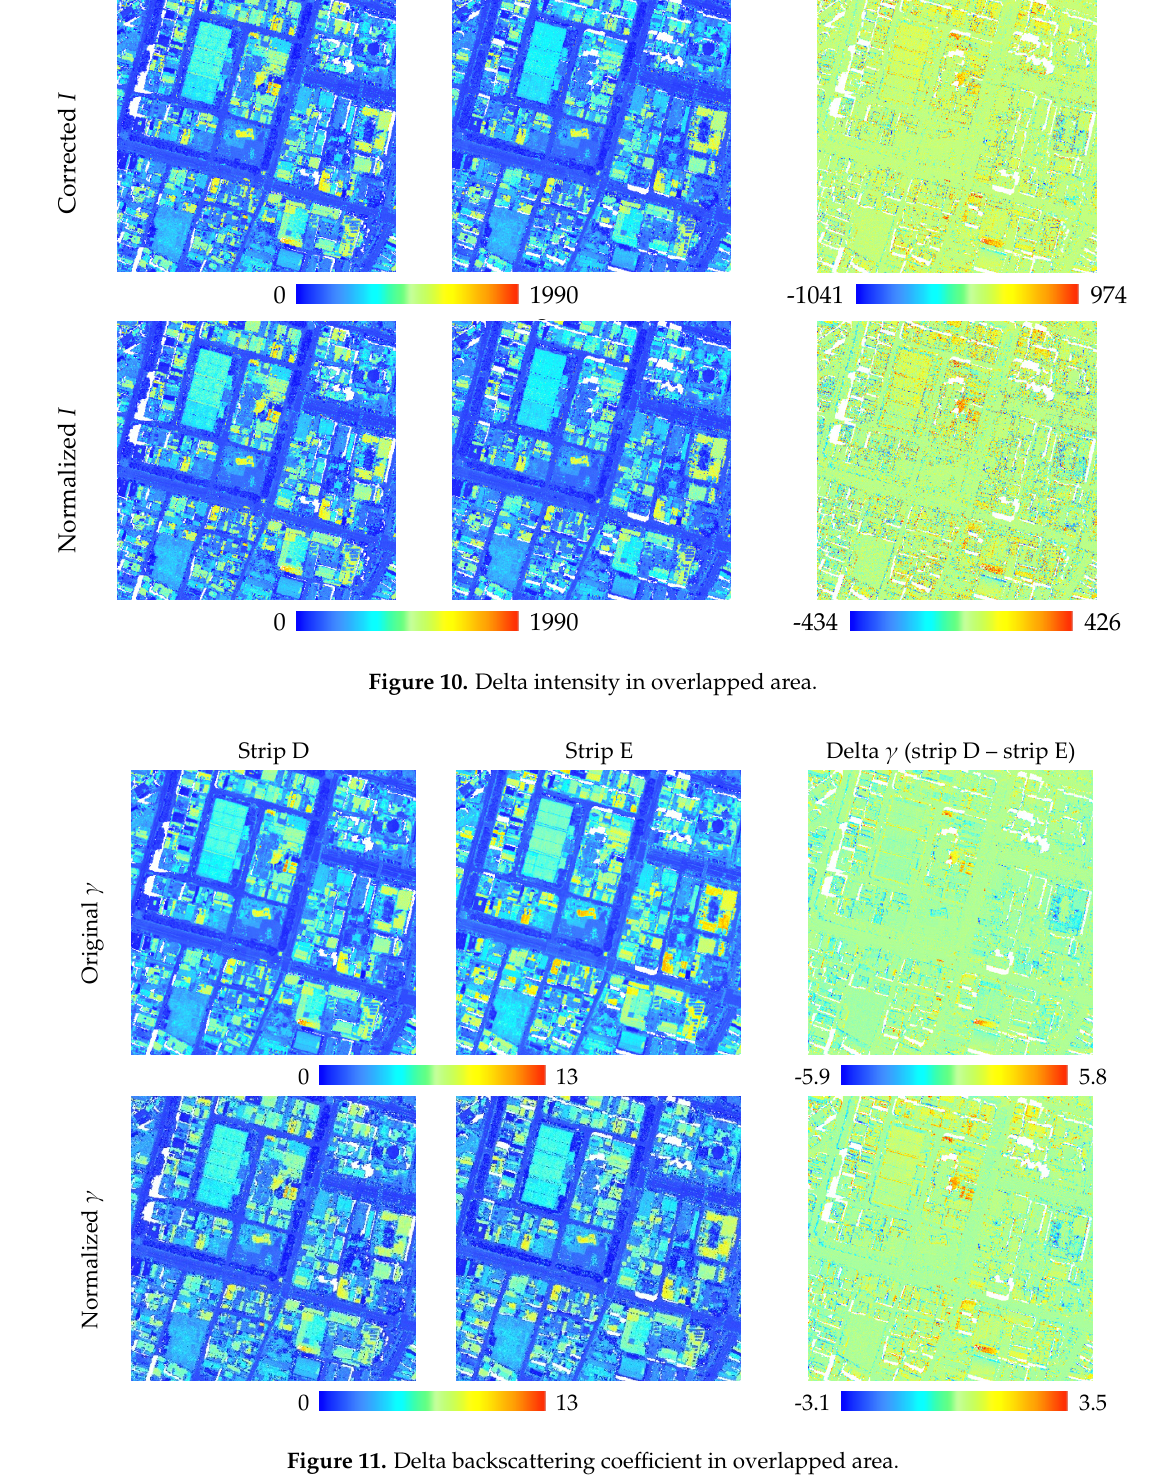
Figure 10. Cont. Figure 10. Cont.